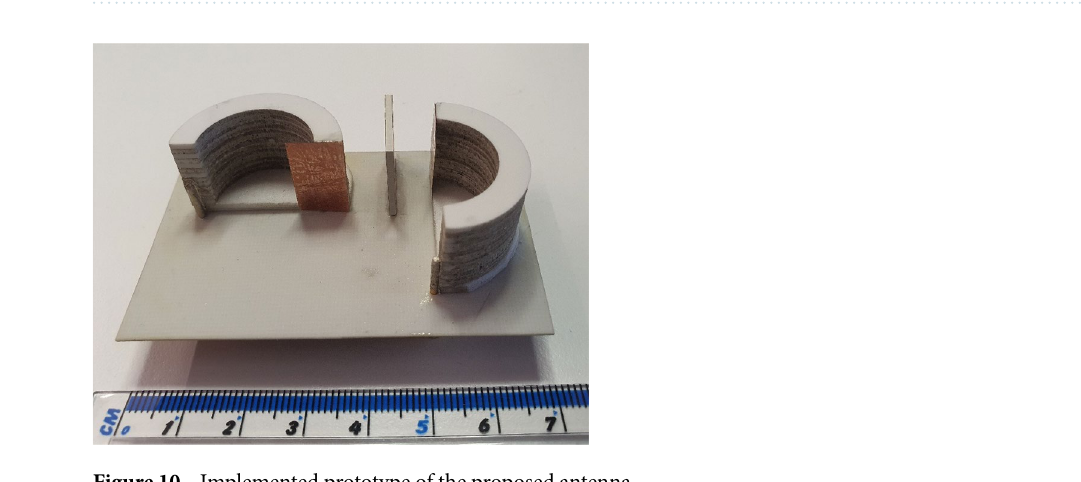
Figure 9. Simulated ( a ) S-parameters and ( b ) AR of the proposed antenna with and without the absorber.